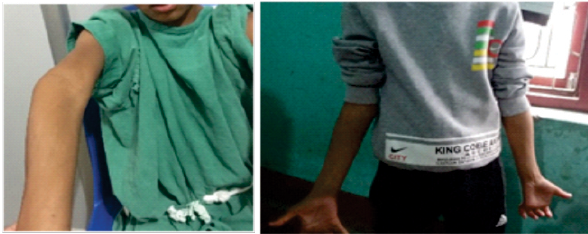
Figure 4: clinical photograph of pre and post dome osteotomy done in 9 years child with post-traumatic cubitus varus deformity of right